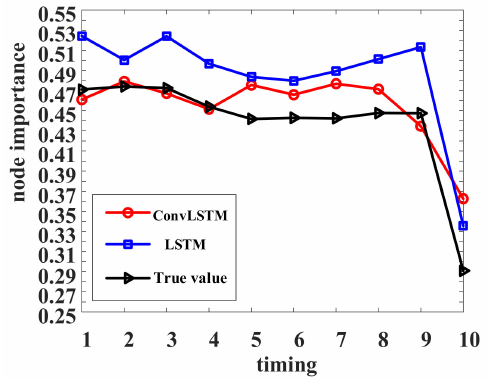
Figure 7. Comparison of prediction values of node importance of IEEE-39 bus system.